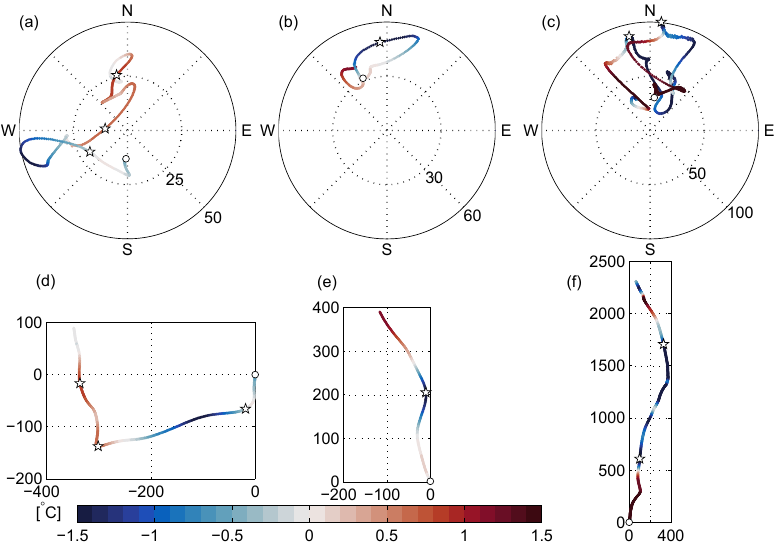
Figure 7. (a, b, c) Hodograph of the mean currents of the upper water column observed at M4 for three case studies ( a – anticyclonic eddy; b – cyclonic eddy; c – dipole). Color represents the temperature recorded at the first SBE37 MicroCATs de-meaned over the time period of each case studies ( a : 9 March–6 April 2015; b : 28 May–10 June 2015; c : 8 April–29 May 2015). The estimated centers of six events have been marked with white stars. The beginning of each time series has been marked with white dots. (d, e, f) Progressive vector diagram for the mean currents of the upper water column observed at M4 for three case studies. Color, time period and symbols are the same as the